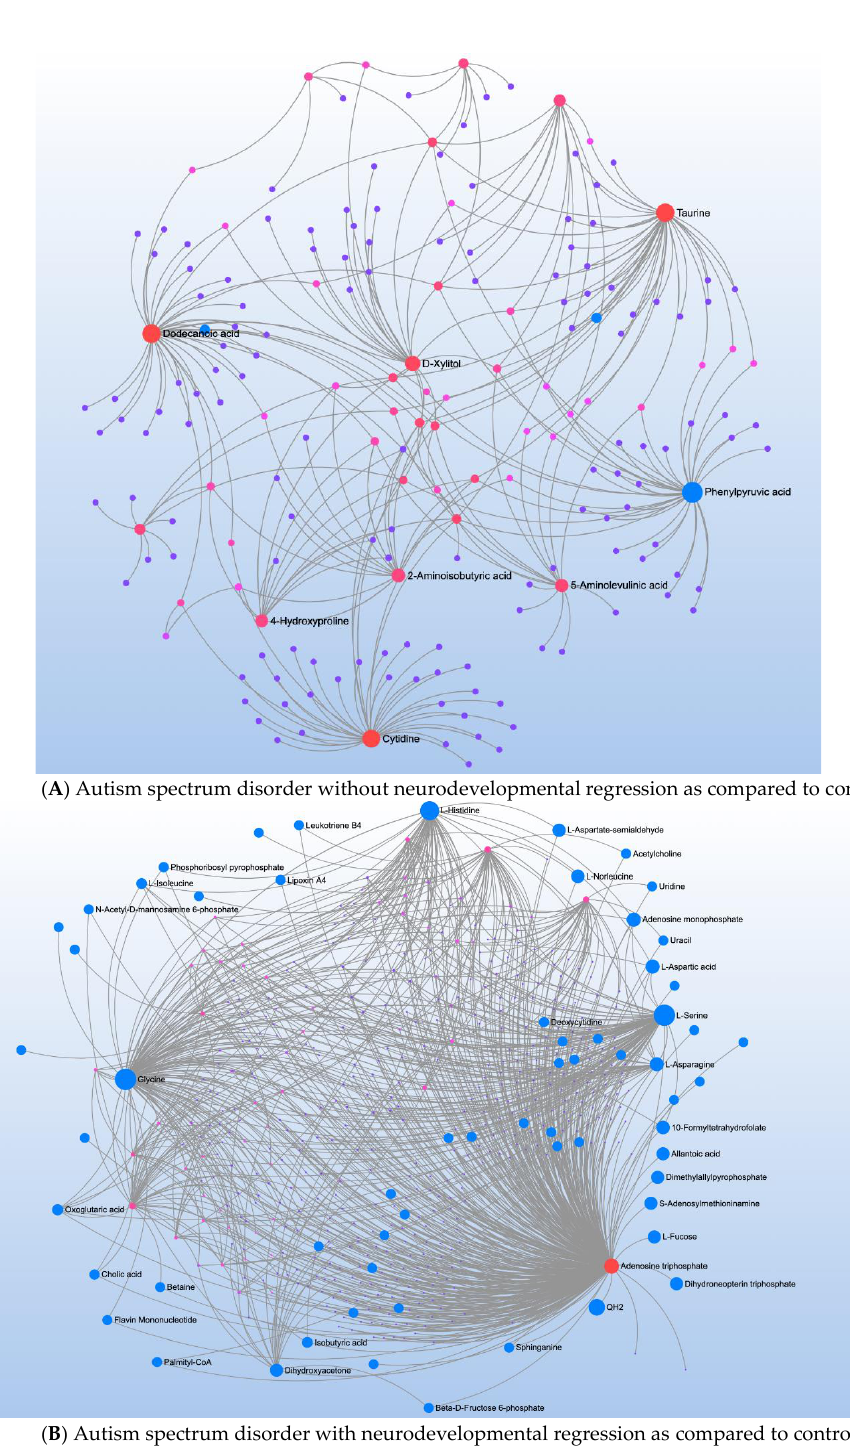
Figure 2. Metabolite-metabolite interaction network for significant metabolites that differentiate participants with ( A ) autism spectrum disorder (ASD) from typically developing controls. Size of the node indicates importance in the network. There were multiple metabolites that appeared to differential the individuals with ASD without a history of neurodevelopmental regression (NDR) from control ( B ), particularly phenylpyruvic acid, a phenylalanine derivative. Controls were differentiated from those with ASD and a history of NDR by several metabolites, particularly adenosine